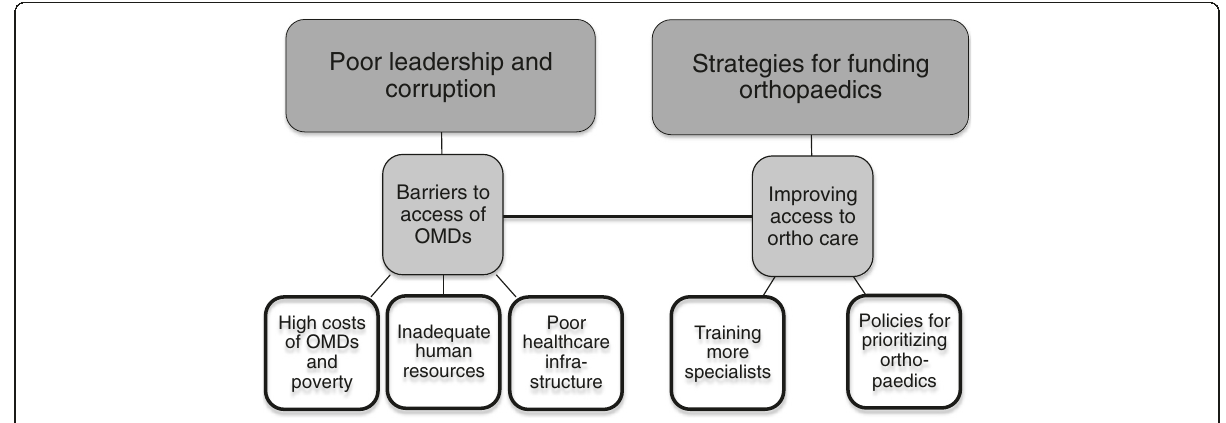
Figure 1 Overarching categories from interview